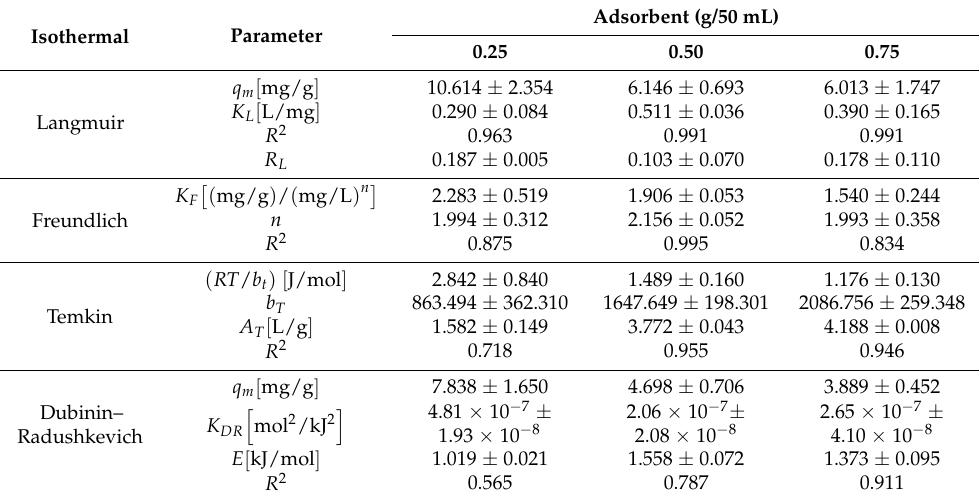
Table 5. Characteristic parameters of the adsorption isotherms model after it was fitted with the experimental data obtained with the CNB—Basic 2RN Navy Blue Dye. Adsorbate concentration 50 mg/L. pH = 6.